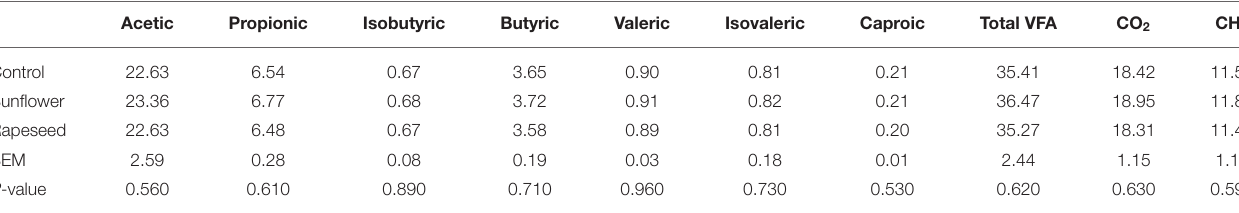
TABLE 5 | Individual volatile fatty acid proportions (VFA; mol/100mol), total VFA (mmol/L), CO 2 mol and CH 4 mol. Acetic Propionic Isobutyric Butyric Valeric